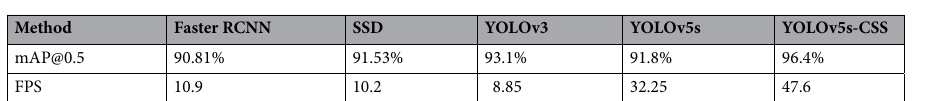
Table 13. Model test performance between different detection